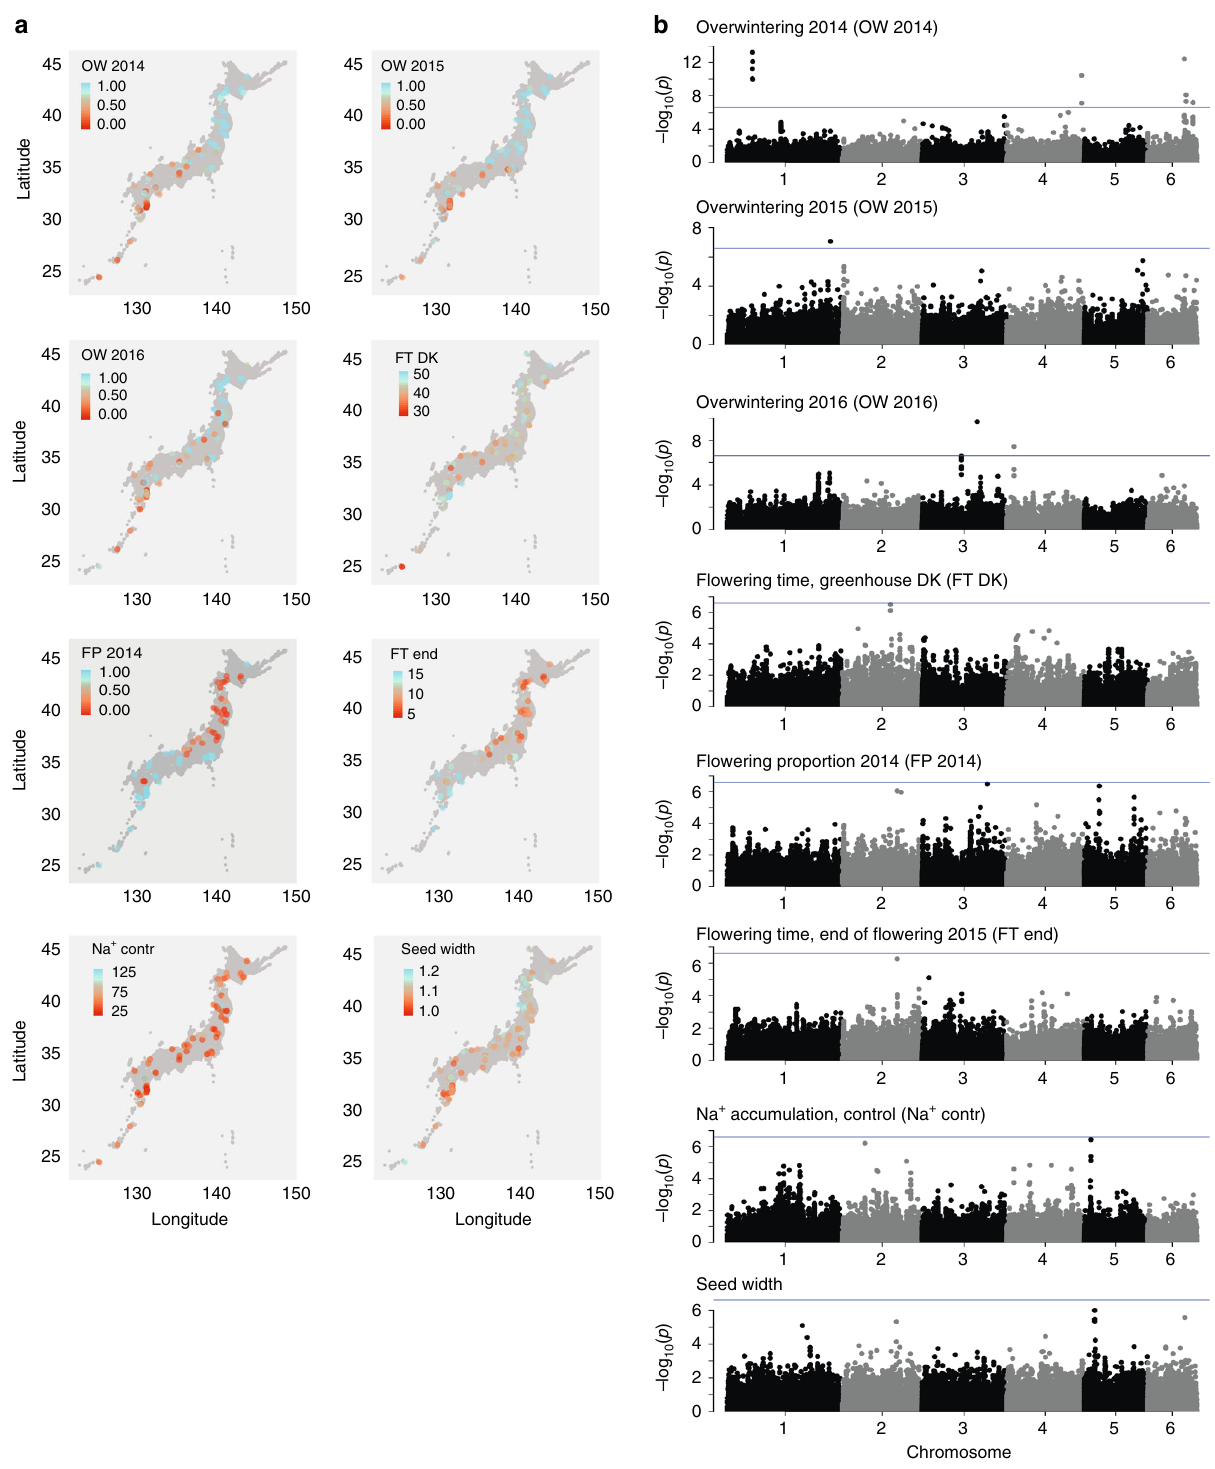
Fig. 5 Phenotype data and GWA analysis. a Heatmaps displaying phenotype data. OW: overwintering, the fraction of plants surviving winter. FT DK: days to fl owering in a greenhouse located at 56.229406 N, 10.126424E, 8380, Trige, Denmark. FP 2014: the proportion of plants fl owering at the Tohoku fi eld site in 2014. FT end: End of fl owering at the Tohoku fi eld site in 2014/2015, quanti fi ed as the number of weeks with fl owers after the fi rst set of mature pods. Na + contr: sodium ion accumulation in roots. Seed width: Width of seeds in mm. b Manhattan plots showing results of GWA scans for the phenotypes indicated. Blue line: Bonferroni threshold, 2.5 × 10 − 7 . Source data underlying b are provided as a Source Data fi